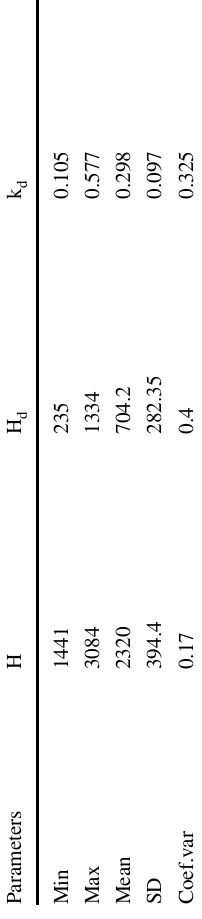
d ) and diffusion coefficient